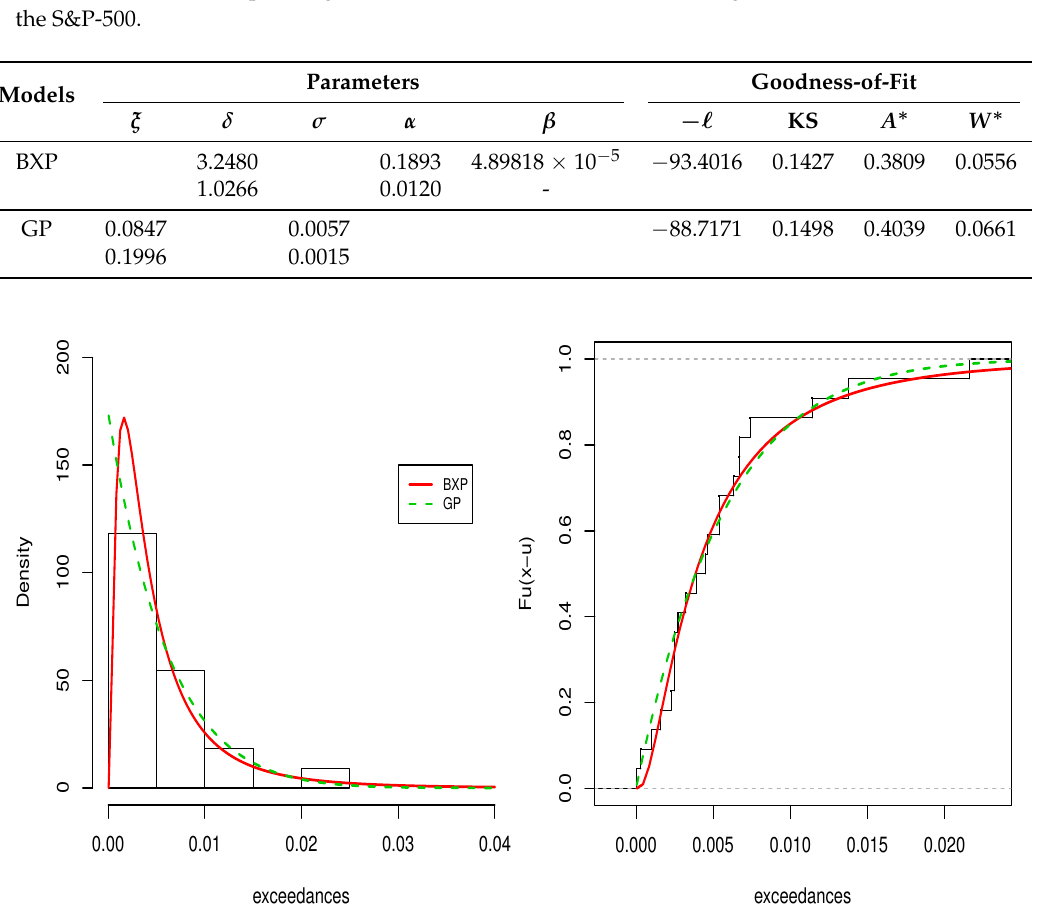
Figure 5. Fitted pdfs ( left ) and cdfs ( right ) of the BXP and GP distribution for the S&P-500 dataset. Here, VaR is estimated with the GP and BXP distribution using the POT method for values